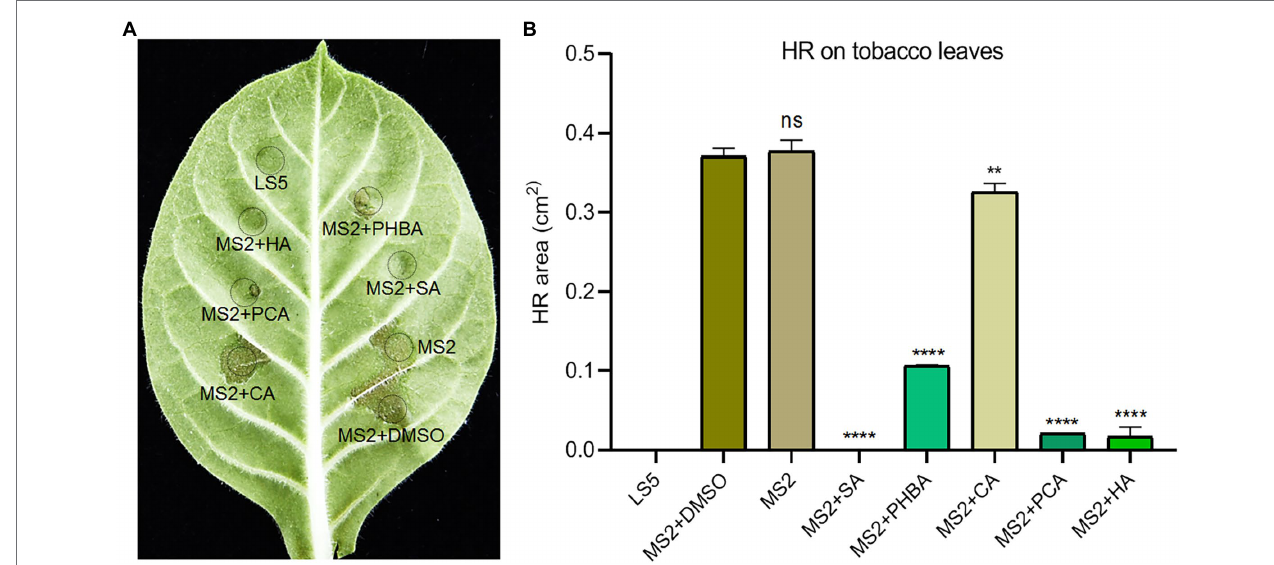
FIGURE 3 | Effects of SA (0.15 mM), PHBA (0.4 mM), CA (0.2 mM), PCA (0.2 mM), and HA (0.5 mM) on the hypersensitive response (HR) induced by MS2 on tobacco leaves. (A) HR symptoms on Nicotiana tabacum K326 leaves. Cell suspensions of MS2 at OD 600 of 0.6 were incubated in the dark with optimal